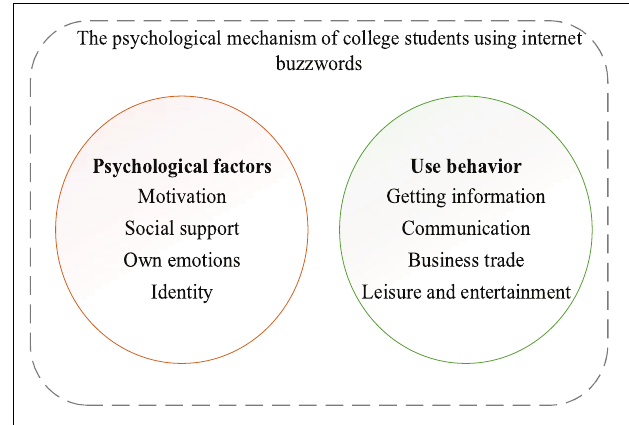
FIGURE 1 | Specific performance of college students using network